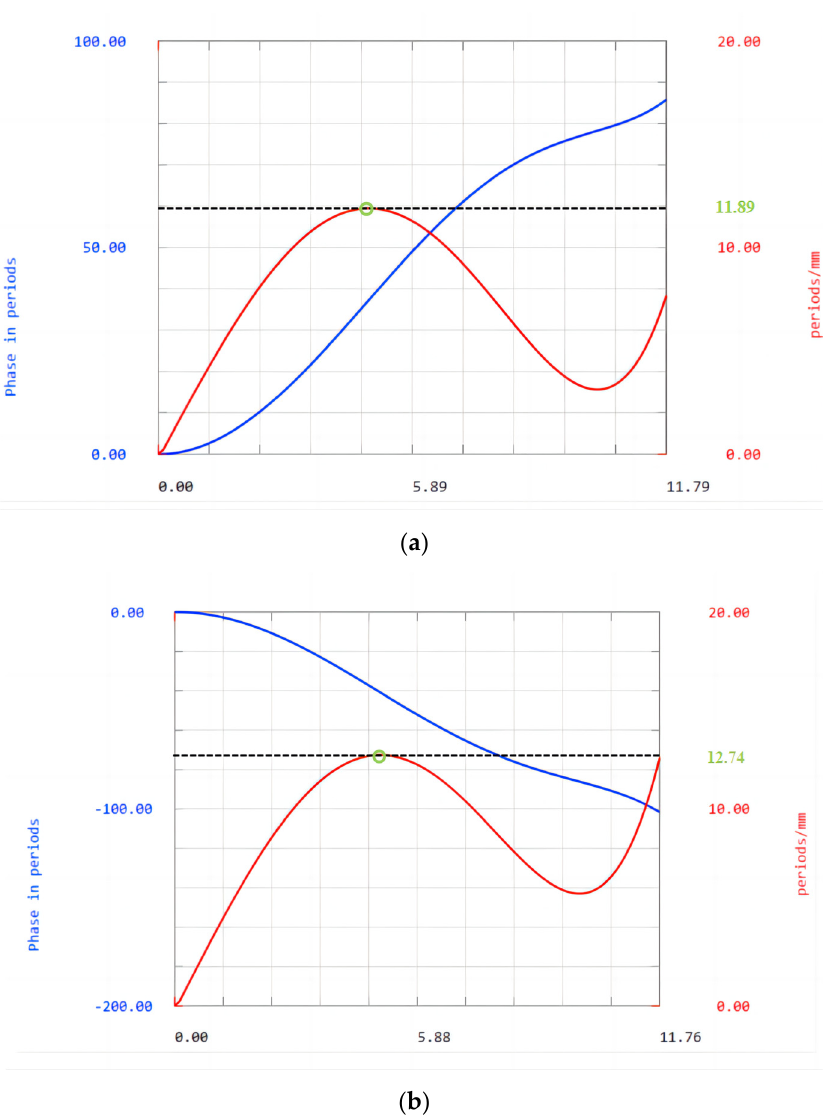
Figure 8. Phase plot of the diffractive surfaces with ( a ) CaF 2 ; ( b ) SiO 2 substrates.